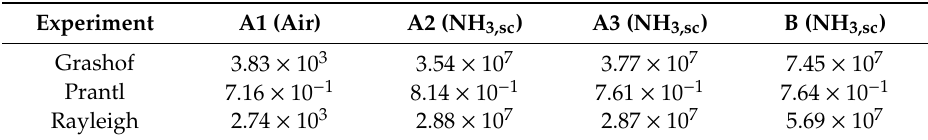
Table 4. Dimensionless numbers characterizing the conducted experiments. For experimental parameters of the experiments see Table